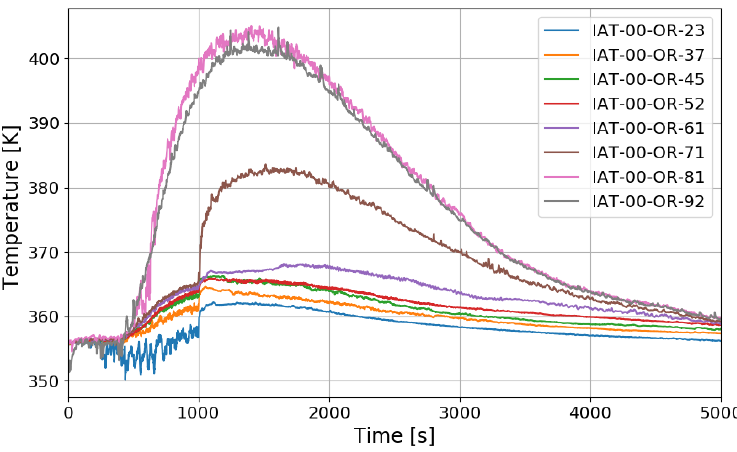
Figure 15. Temperature distributions along a center line for the SP3 test.